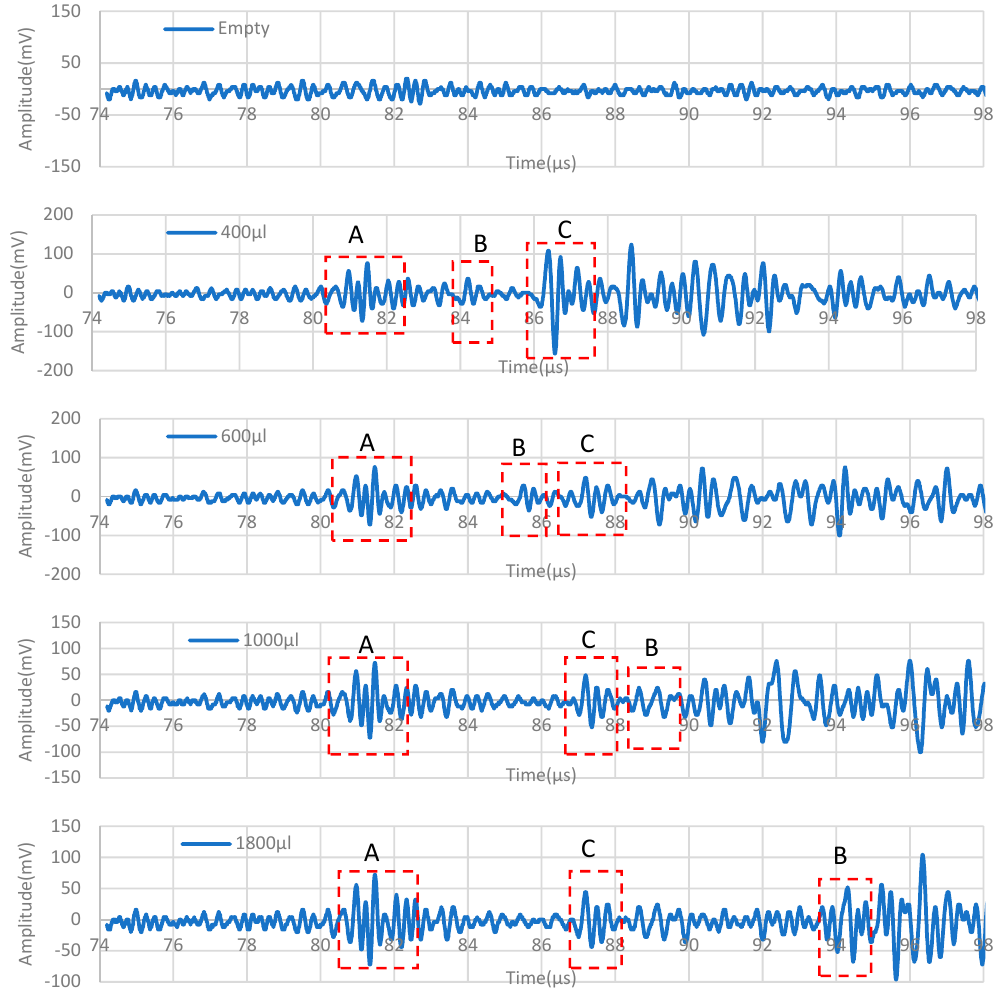
Figure 6. Time domain responses for the reflected wave from the liquid for all cases.